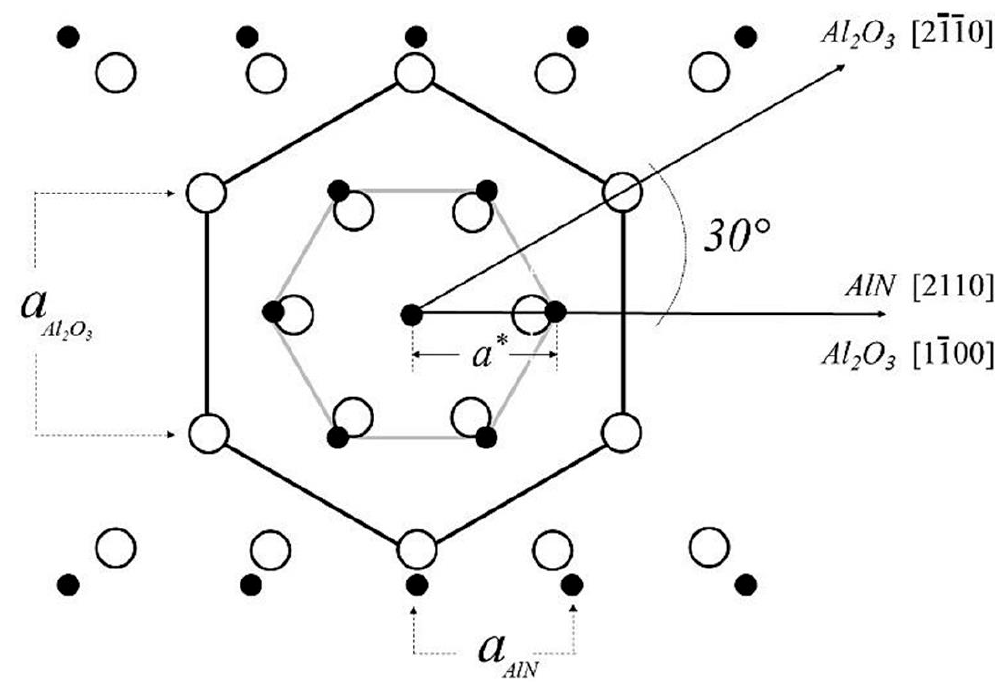
Figure 4. Top view of the epitaxial relationship between AlN (0001) and sapphire (0001) with 30 ◦ rotation with respect to each other. The distance marked as “ a ” is the separation between O 2 − atoms in sapphire [14]. (Reproduced from [14] with some modifications).